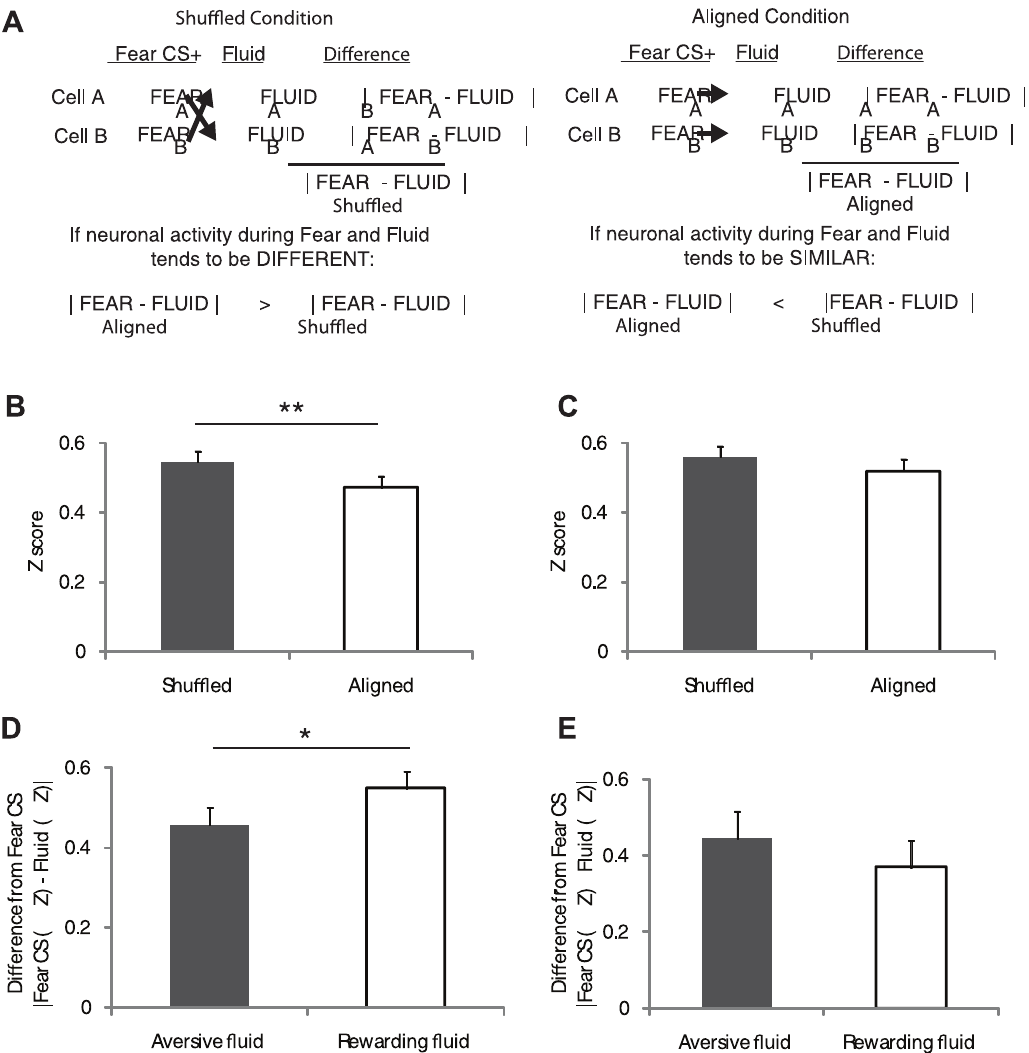
Figure 3. Neuronal activity during affective stimuli. ( A ) Design of aligned versus shuffled comparisons. If neuronal activity is similar during the affective stimuli, then the difference in the aligned condition should be less than the difference in the shuffled condition. If neuronal activity is different during the affective stimuli, then the difference in the aligned condition should be greater than the difference in the shuffled condition. ( B ) Valence-congruent comparison. Activity during fear CS and aversive fluid infusion is more similar than expected by chance (n=84 cells). ( C ) Valence-incongruent comparison. Activity during fear CS and rewarding fluid infusion is not more similar than expected by chance (n=84 cells). ( D ) Non-SD cells. Valence-congruent comparison of activity is more similar than valence-incongruent comparison (n=62 cells). ( E ) SD cells. No significant difference between valence-congruent and valence-incongruent comparison of activity (n=22 cells). Values represent mean + / 2 standard error of the mean. * P , .01, ** P , .0001.